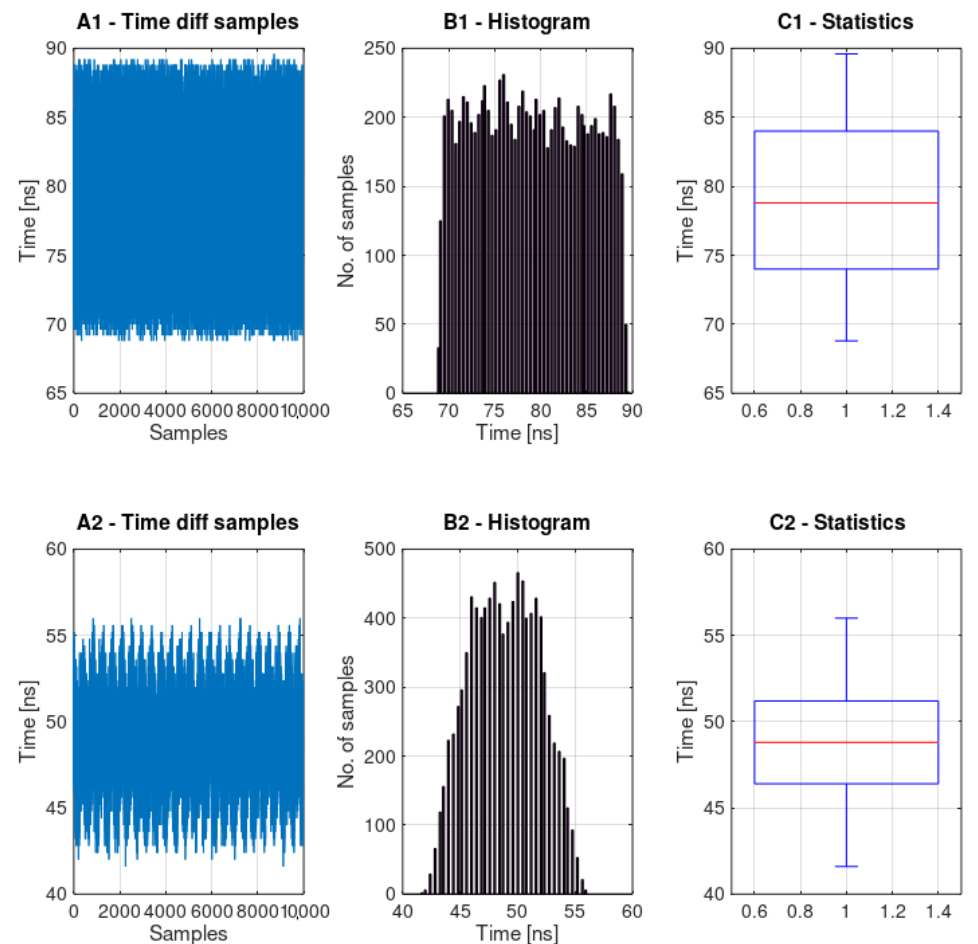
Figure 10. Sampling signal measurement data statistical analysis. A1 —sampling signal delay from PPS for PMU-A, B1 —histogram of sampling signal delay for PMU-A, C1 —box plot of sampling signal delay for PMU-A. A2 , B2 , C2 —accordingly for PMU-B.